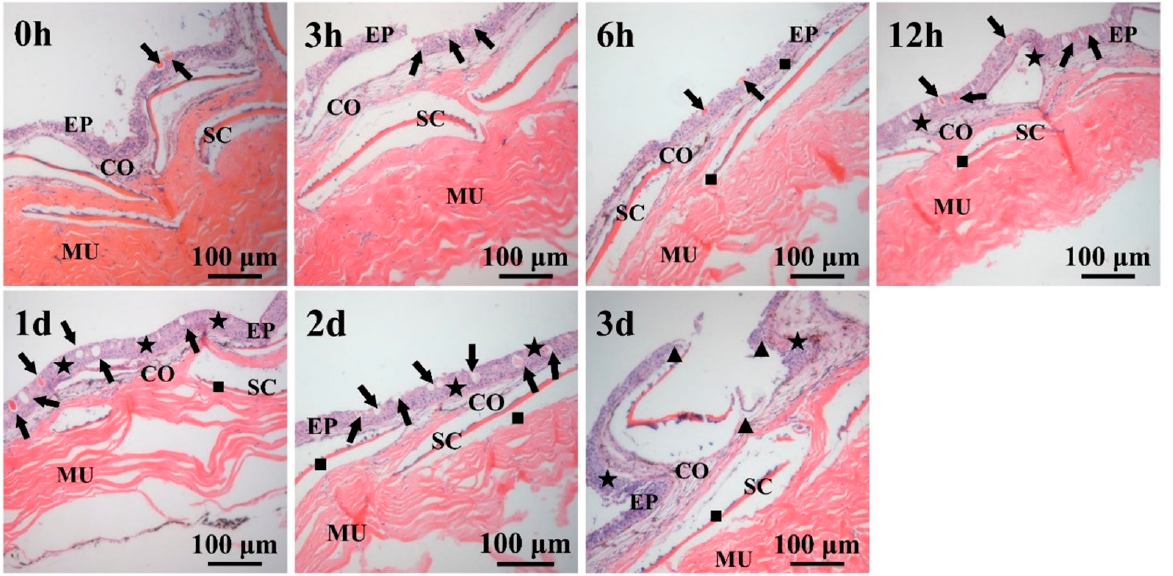
Figure 2. HE staining of the skin tissue of T. ovatus infected by C. irritans. Abbreviations: EP: epidermis layer; CO: dermis layer; MU: muscle layer; (cid:78) : break; (cid:4) : flat; (cid:70) : thickening; the